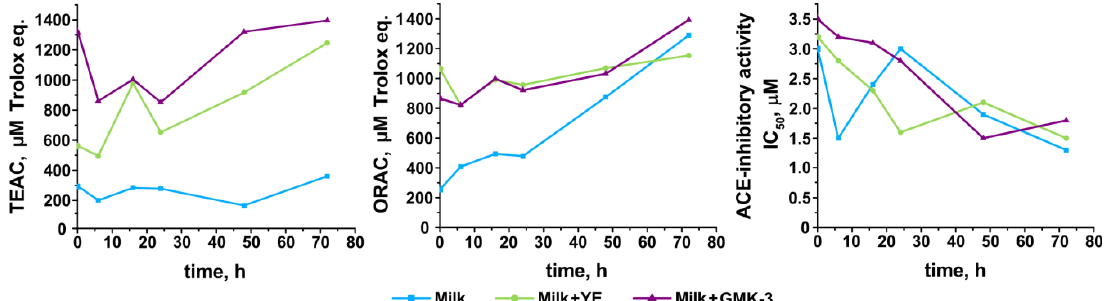
Figure 5. Antioxidant and ACE-I properties of products obtained after fermentation by B. longum MC-42 of Milk —skim milk; Milk + YE —skim milk with addition of yeast extract, and Milk + GMK-3 —skim milk with addition of hydrolysate containing supplementation GMK-3.